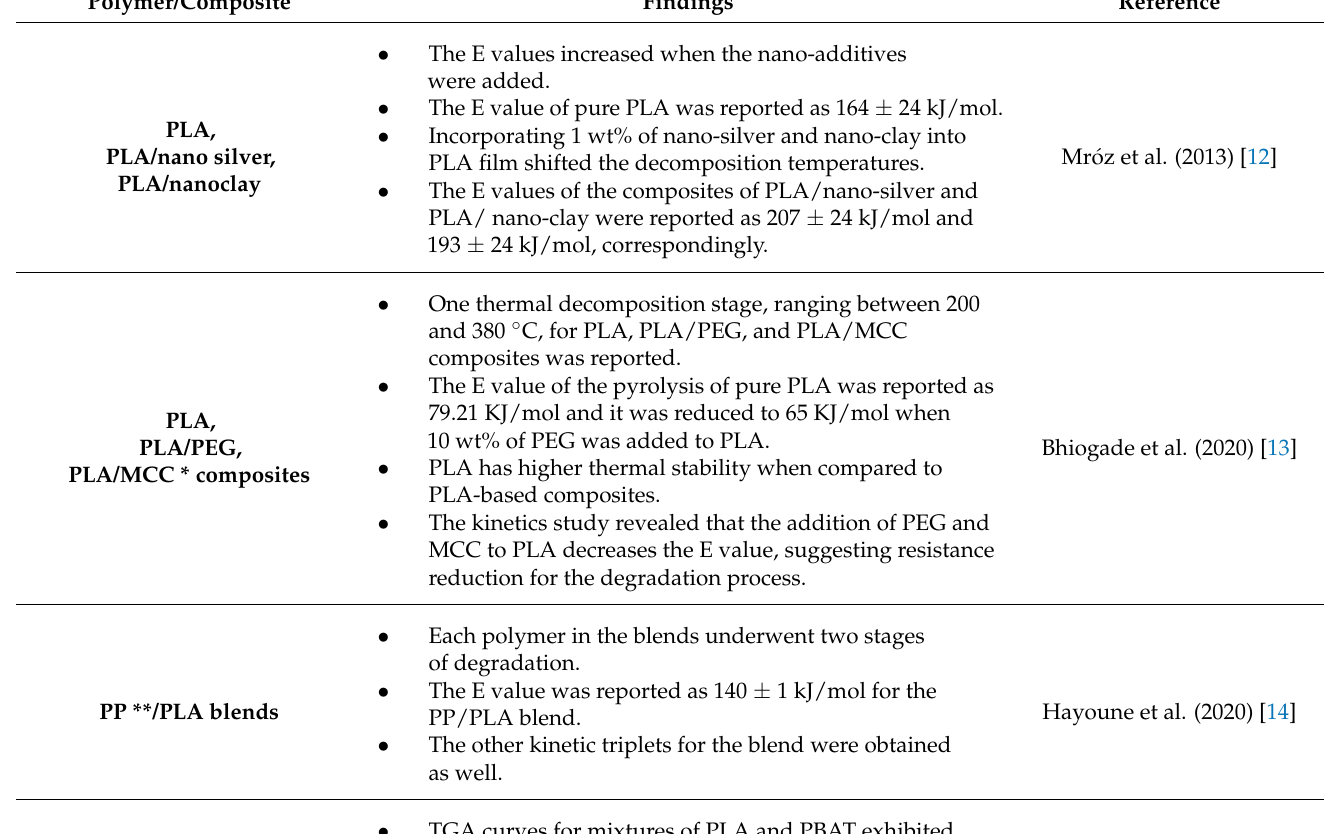
Table 1. Some of the PLA and different polymers pyrolysis research work. Polymer/Composite